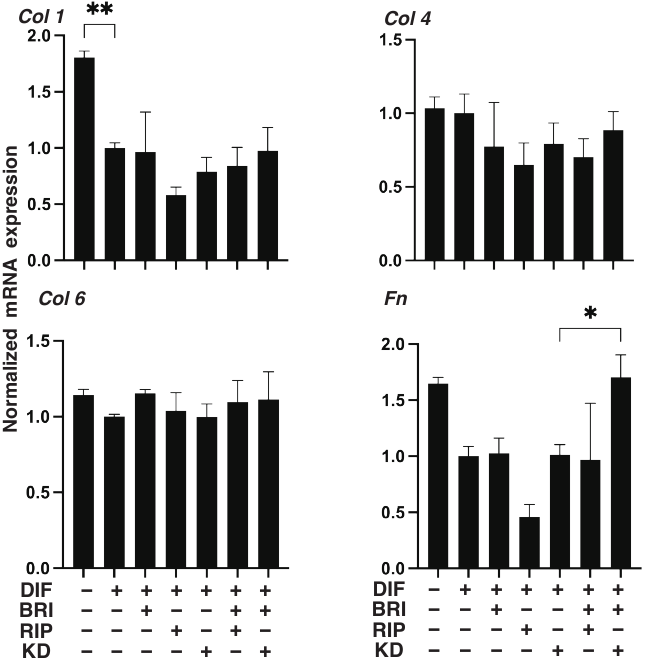
Figure 6. Effects of ROCK-i and/or BRI on the mRNA expression of ECMs in 3T3-L1 3D spheroids. The 3T3-L1 cells were 3D-cultured under several conditions: preadipocytes of 3T3-L1 cells (DIF−) and their adipogenic differentiation (DIF+) with or without 10 µM ripasudil (Rip) or KD025, and / or BRI were subjected to qPCR analysis to estimate the mRNA expression of ECM milecules (Col1: collagen 1, Col4: collagen 4, Col6: collagen 6, Fn: fibronectin). All experiments were performed in triplicate using fresh preparations, each consisting of five samples. Data are presented as the arithmetic mean ± standard error of the mean (SEM). * p < 0.05, ** p < 0.01, and other pairs were not statistically significant (ANOVA followed by a Tukey’s multiple comparison test).